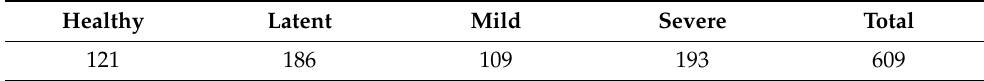
Table 1. Distribution of the Figure 4. Images of litchi fruit at different disease stages: ( a ) healthy, ( b ) latent, ( c ) mild and ( d ) severe.